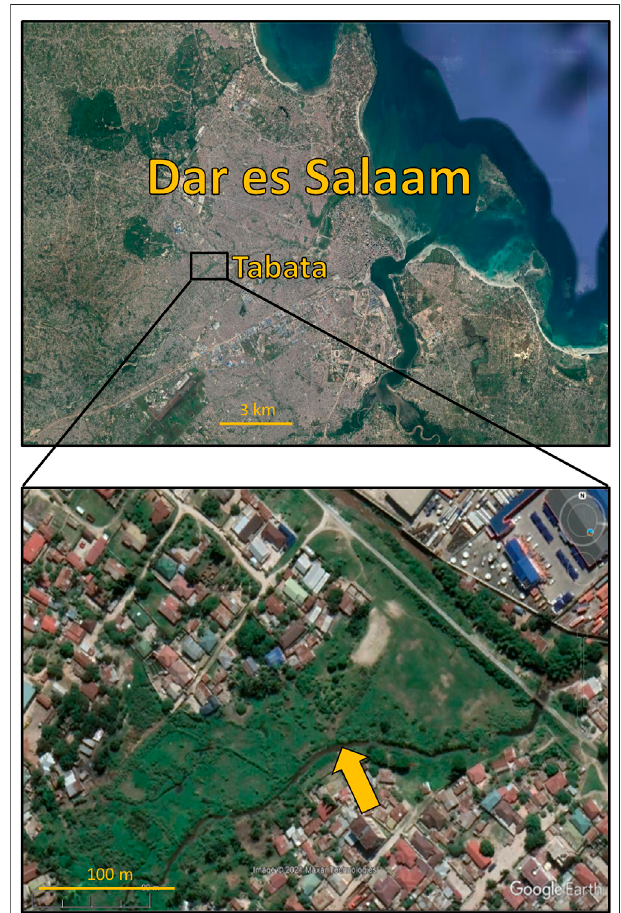
FIGURE 1 | Sampling location for sediment cores marked with arrow. Map from Google